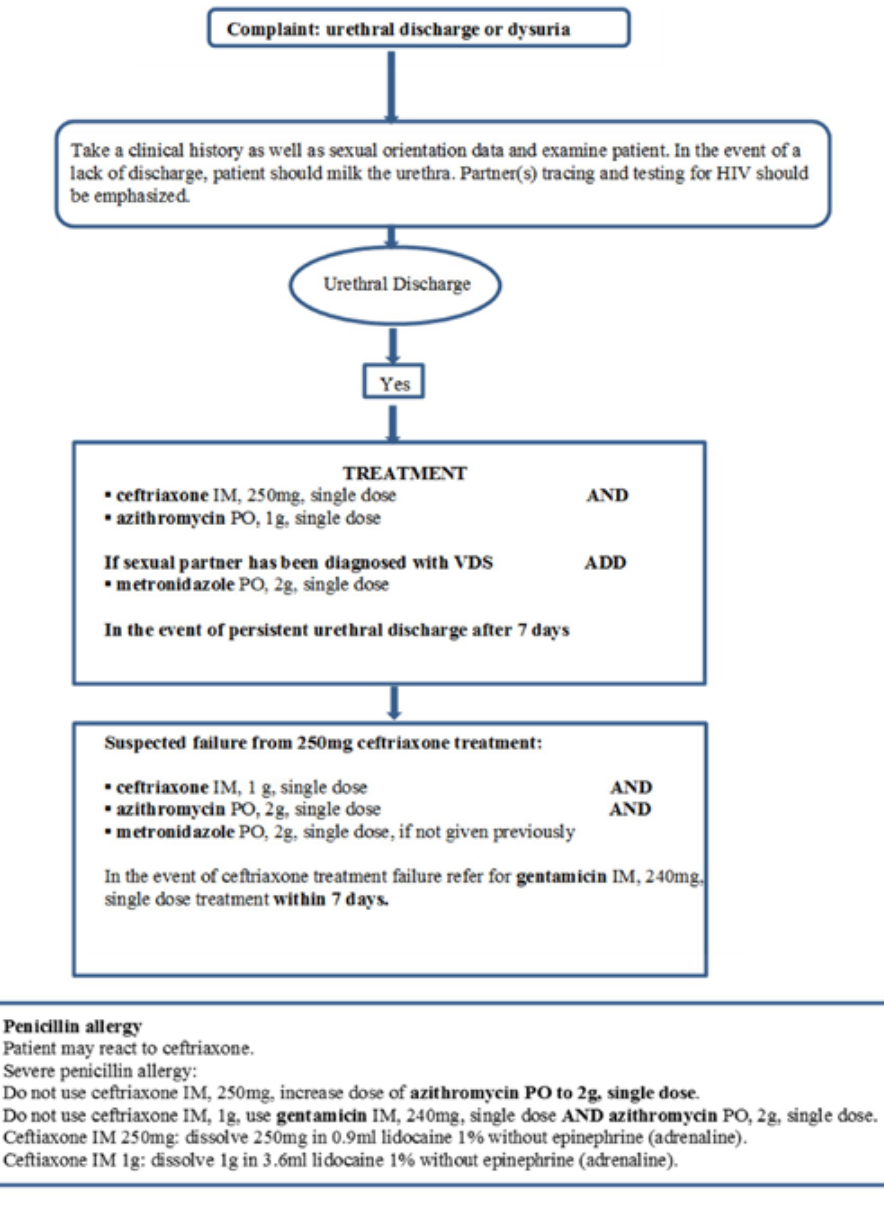
Figure 3: Flowchart of syndromic treatment of Male Urethritis Syndrome. (adapted from the revised MUS flowchart of the Primary Health Care Standard Treatment Guidelines and Essential Drugs List, 2015)